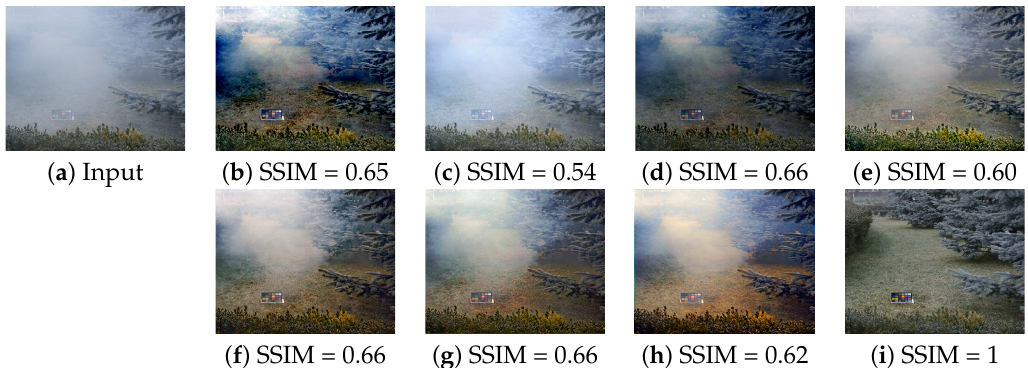
Figure 6. Comparison of dehazed image using O-Haze: ( a ) Haze input, ( b ) NL, ( c ) DCPDN, ( d ) RRO, ( e ) TCN, ( f ) DVNet-NL, ( g ) DVNet-RRO, ( h ) DVNet-NYU, and ( i ) Ground